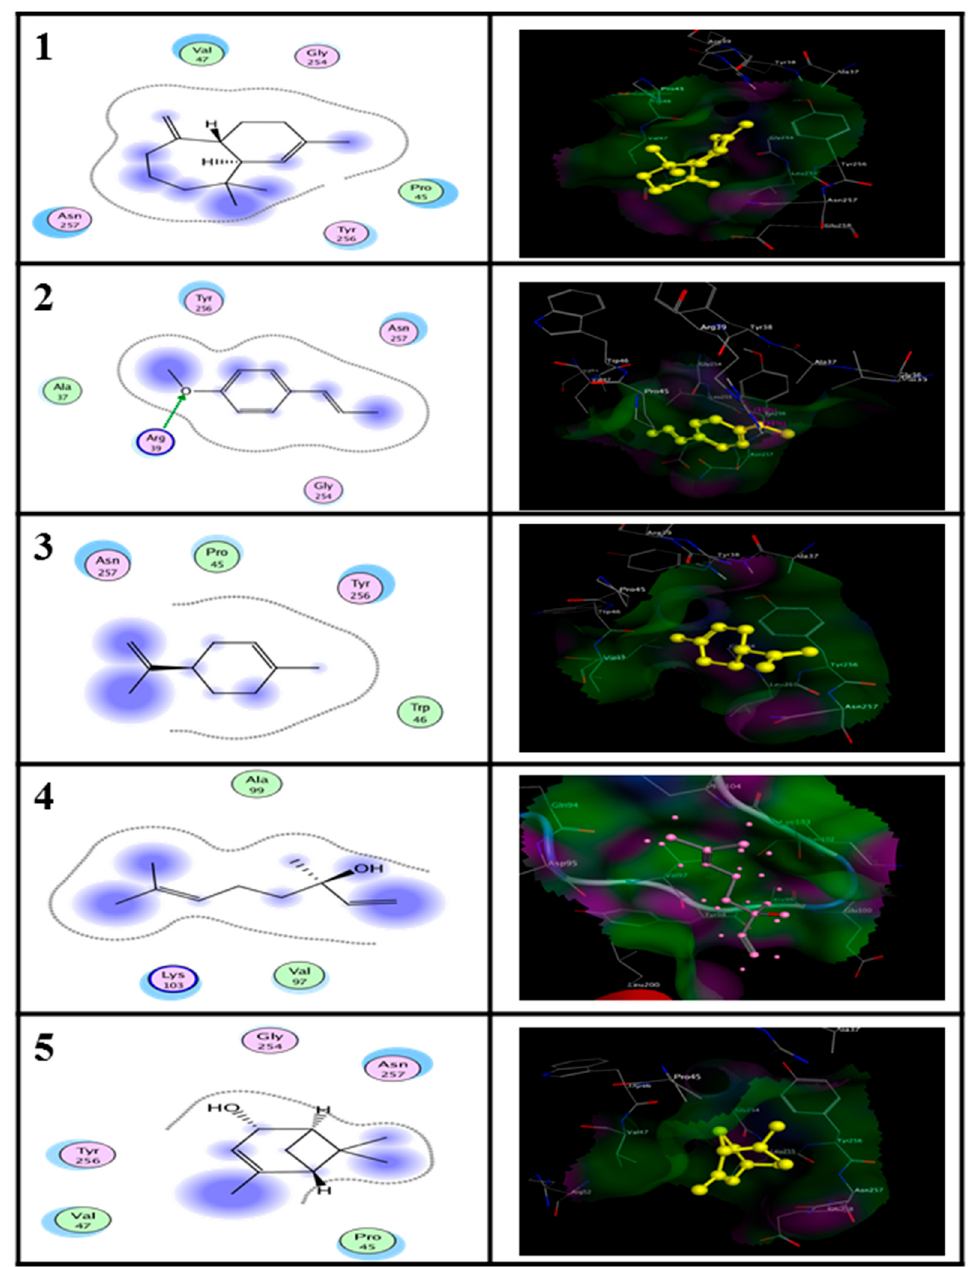
Figure 5. Molecular docking of essential oil (EO) and nanoemulsion (NE) ligands of Pimpinella anisum with homology modeled Aspartate aminotransferase (AST) of Tribolium castaneum created by Molecular Operating Environment (MOE) program.